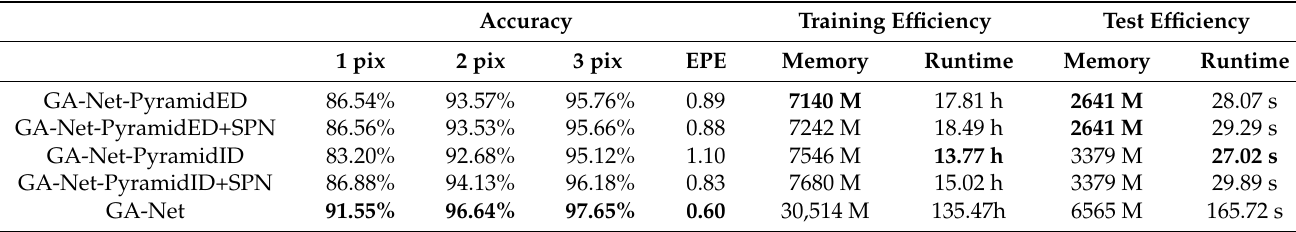
Table 2. Accuracy and efficiency comparison between GA-Net-Pyramid, including GA-Net- PyramidED and GA-Net-PyramidID, and GA-Net on KITTI-2012